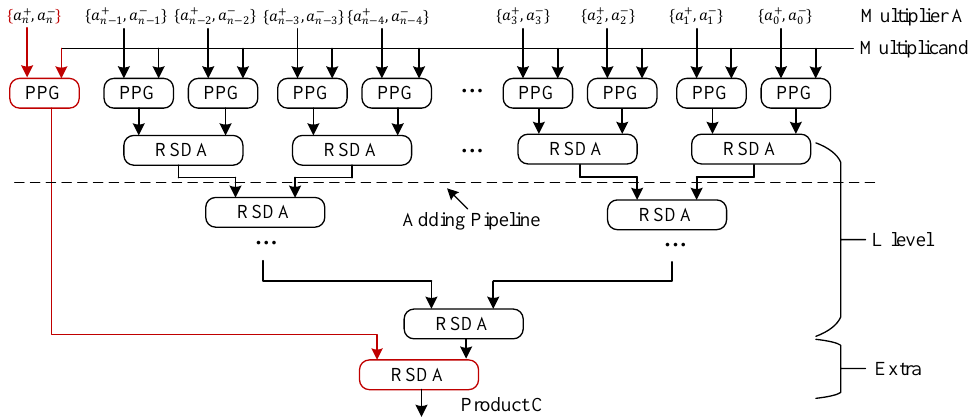
Figure 4: The architecture of the proposed RSD